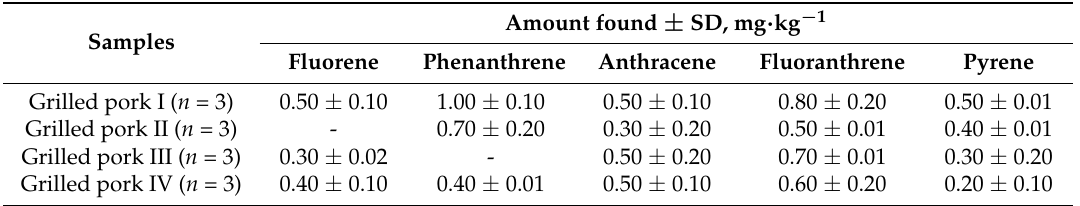
Table 2. The determination of polycyclic aromatic hydrocarbons in the studied grilled pork samples ( n = 3). Samples